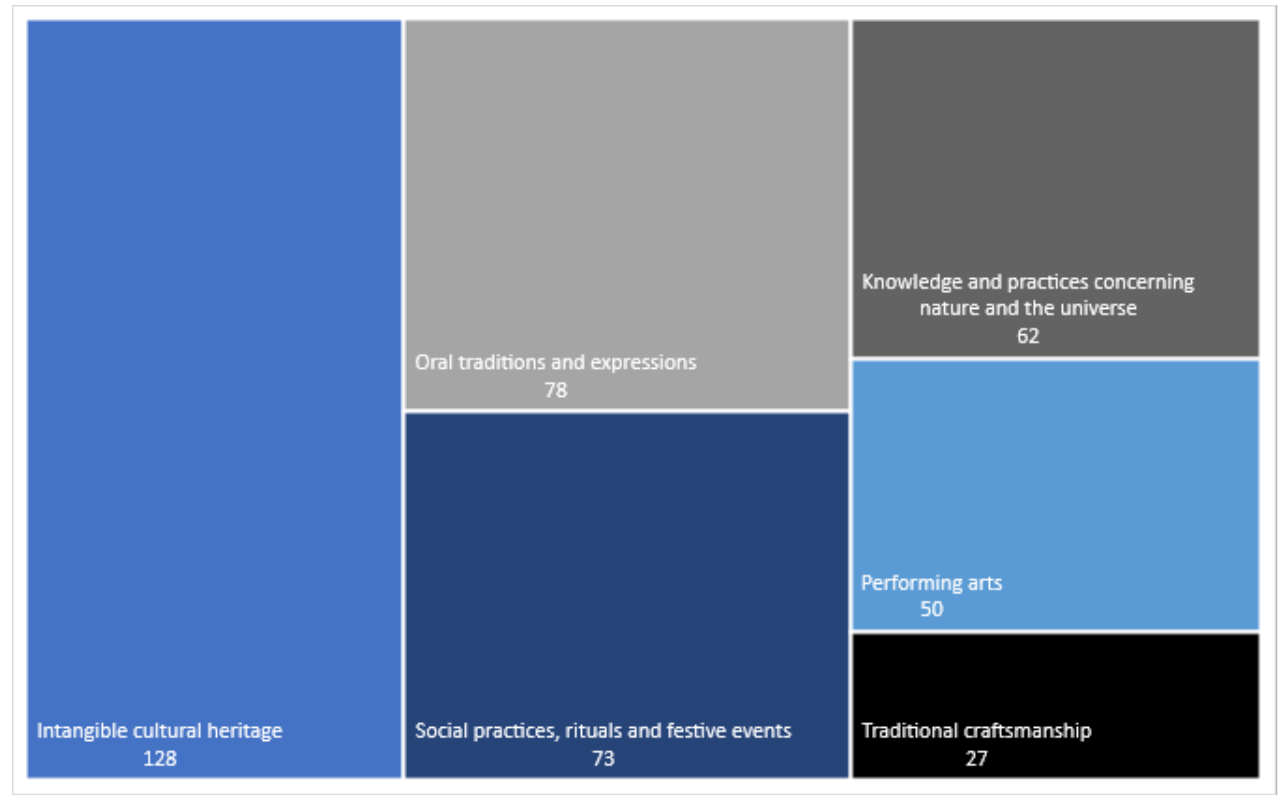
Figure 2. Tree map with the categories of papers extracted from WOS (after deleting repeated ones). Source: edited by authors.